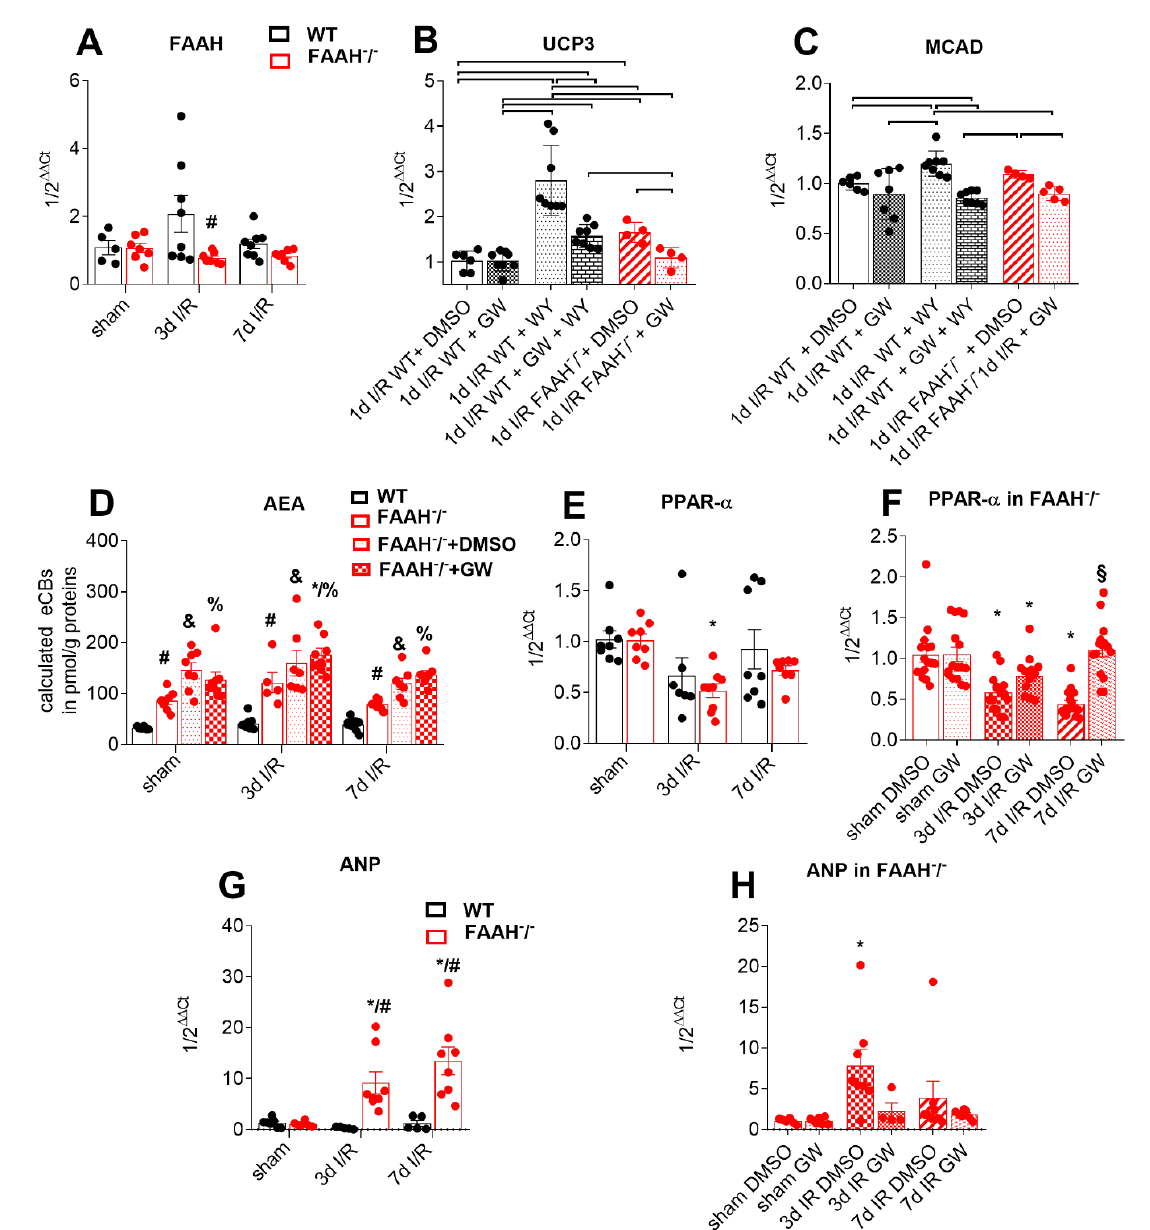
Figure 2. Proof of principle. ( A ) Lower FAAH mRNA levels in FAAH − / − group. PPAR- α downstream gene UCP3 and MACD activation with agonist WY14.634 and its inhibition with antagonist GW6471 are shown in ( B , C ). ( D ) LC-MS reveals increased AEA levels in the FAAH − / − group compared to WT, remaining unchanged by PPAR- α antagonist GW6471 and DMSO. ( E ) FAAH − / − mice show more substantial downregulation of PPAR- α mRNA levels, and ( F ) those levels were restored by GW6471. ( G ) ANP is upregulated in FAAH − / − group compared to WT, being reduced ( H ) after GW treatment. RT-qPCR using Taqman ® , expression is related to sham and GAPDH using comparative ∆∆ Ct method. AEA, Anandamide; ANP, natriuretic Peptide A; DMSO, Dimethyl sulfoxide; FAAH, fatty acid amide hydrolase; MCAD, Medium Chain Acyl CoA Dehydrogenase; PPAR- α , Peroxisome proliferator-activated receptor-alpha; UCP3, uncoupling protein 3; WT, wild-type; *, p < 0.05 vs. respective sham; #, p < 0.05 FAAH − / − vs. WT at the same time point; §, p < 0.05 FAAH − / − +GW vs. FAAH − / − +DMSO at the respective time point; &, p < 0.05 FAAH − / − +DMSO vs. WT at the respective time point; %, p < 0.05 FAAH − / − +GW vs. WT at the respective time